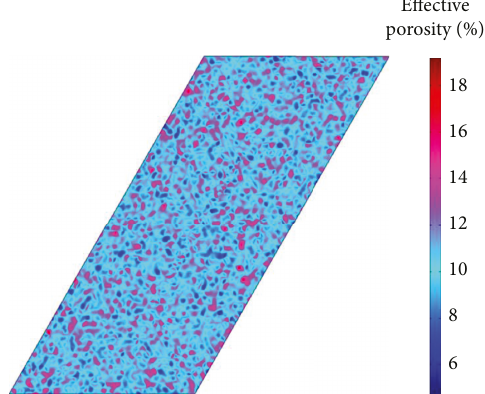
Figure 7: Weibull distribution for initial e ff ective porosity.